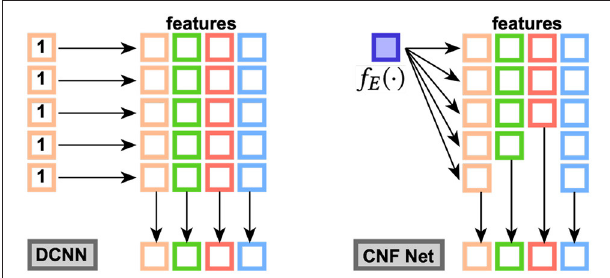
FIGURE 5 | Ablation Test for DSAG: neither means no censor and consistence loss, while both indicates using both censor and consistence loss. Left to right are c432, c499, c880